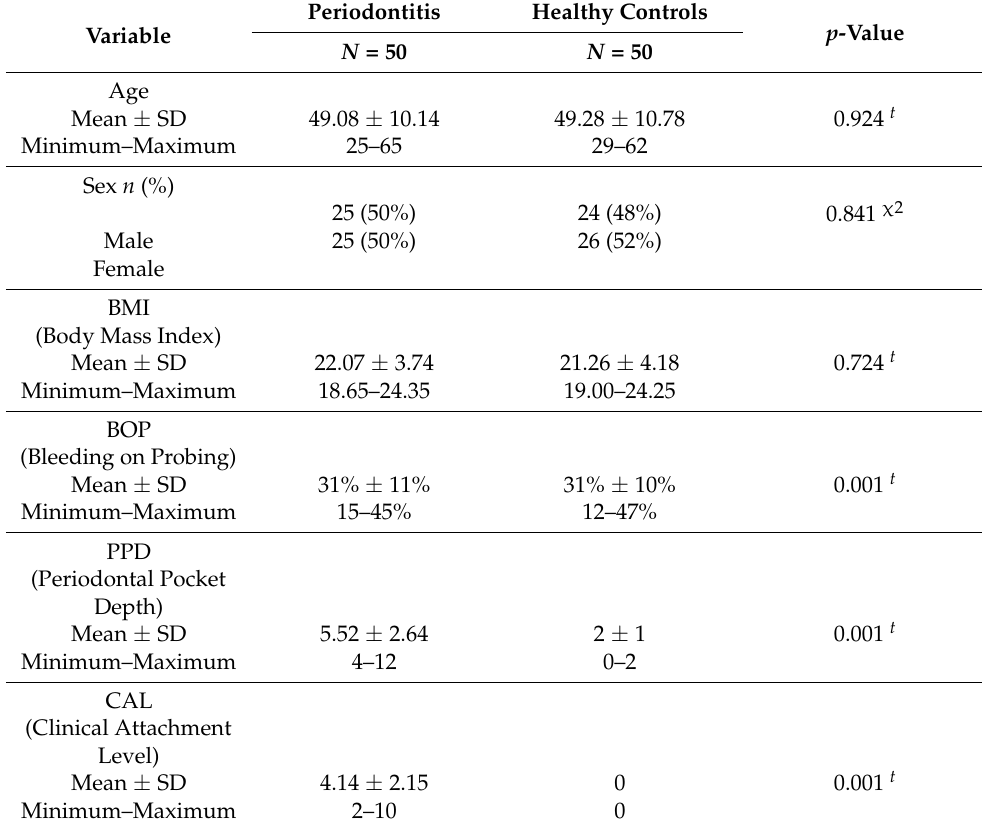
Table 1. Demographic information of the study